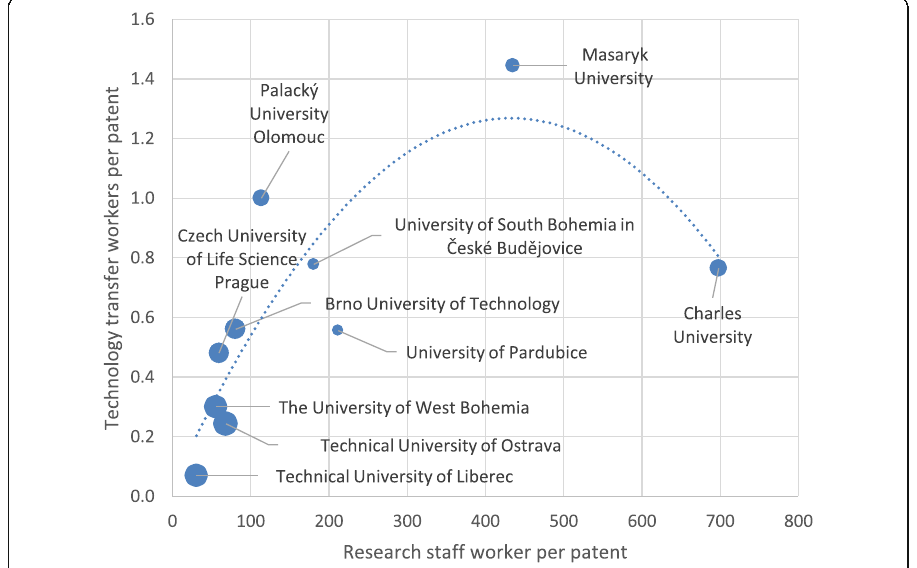
Fig. 4 Research and technology transfer efficiency influence on the total patent